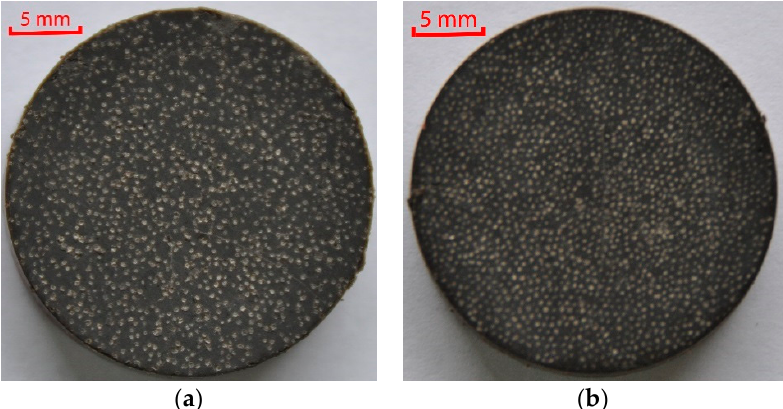
Figure 11. Surface of the core plug sample with a diameter of 2.54 cm after the embedment test: (a) Top; (b) Bottom.